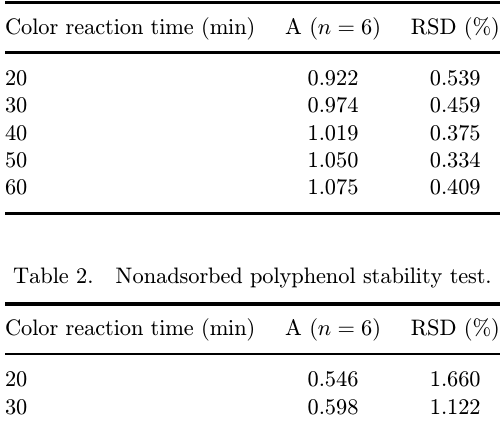
Table 1. Total phenol stability test.